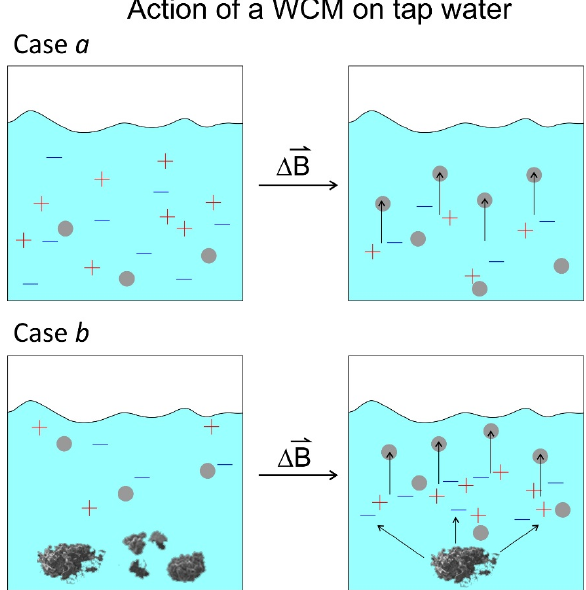
Figure 12. Simplified sketch of the two cases of a WCM acting on tap water. Case a: no precipitate is present, and the field induces DOLLOP formation (small grey circles). Case b: If a precipitate is present, DOLLOPs are formed as well, and the precipitate is dissolved.